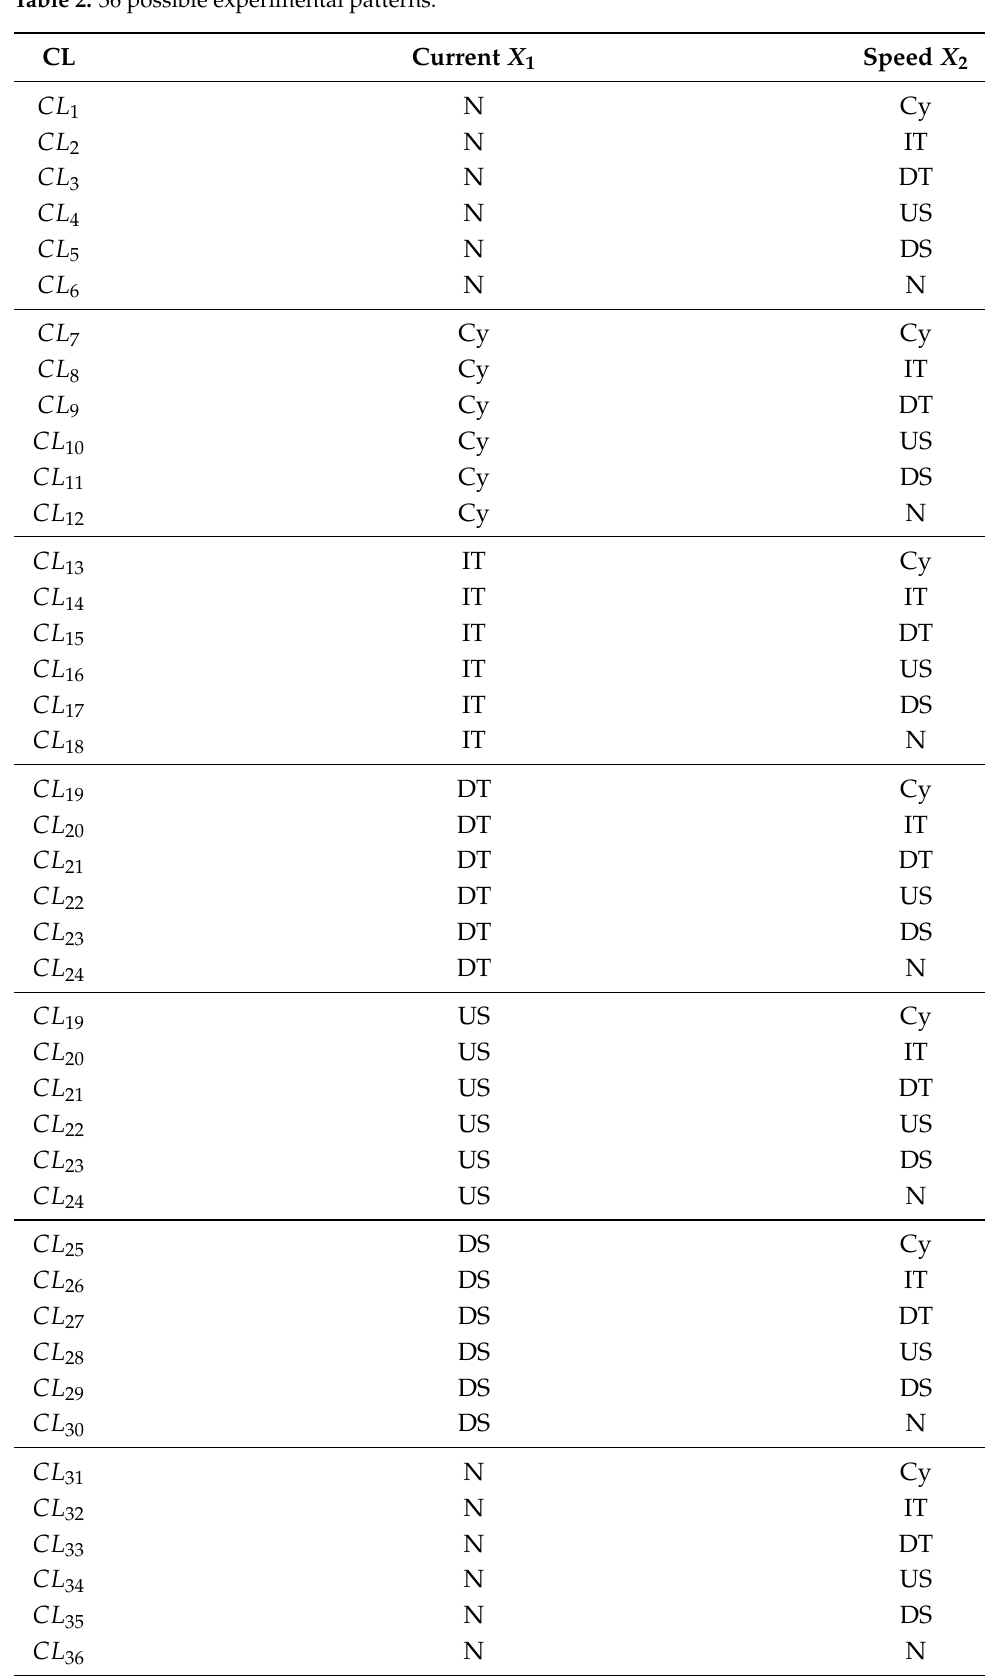
Table 2. 36 possible experimental